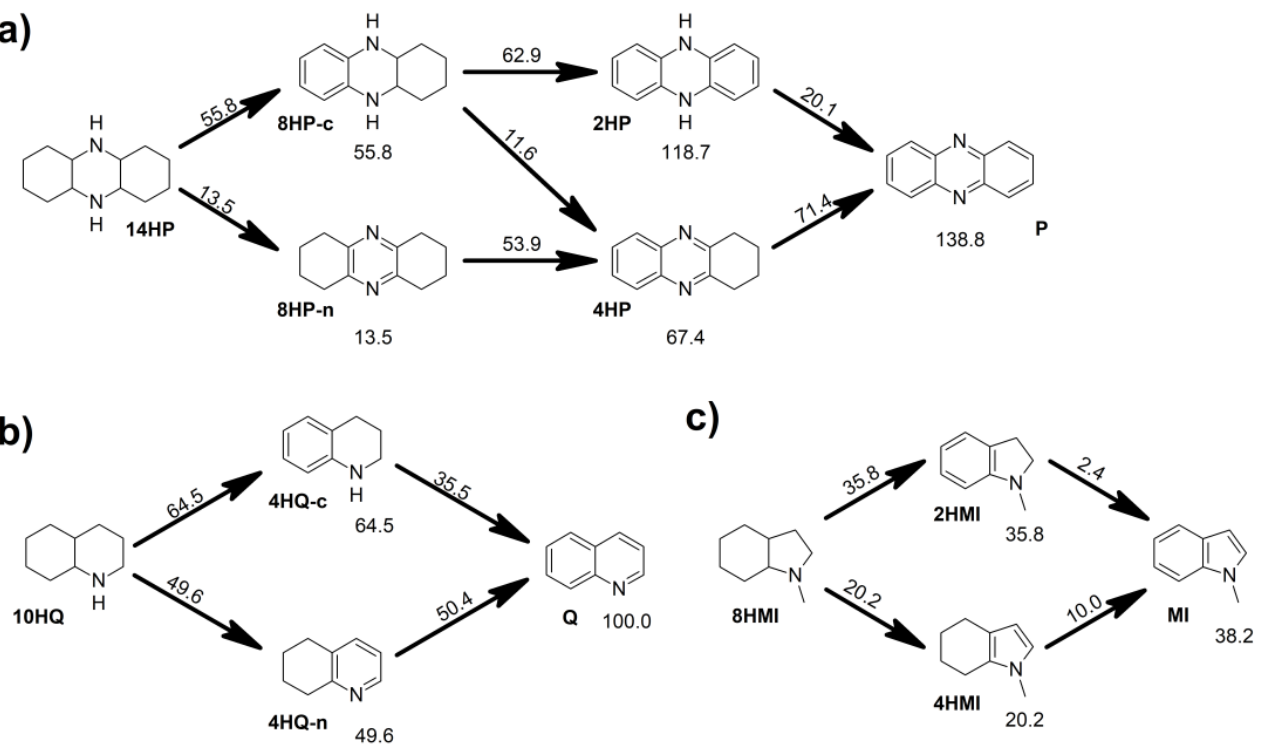
Figure 5. Thermodynamic profile of possible reaction pathways for: ( a ) 14HP, ( b ) 10HQ and ( c ) 8HMI. Values of potential-free energies (kJ/mol) shown below structural formulas for all compounds and intermediates were relative to initial, fully hydrogenated compounds for which respective enthalpies of formation was set to zero. Values (kJ/mol) shown above arrows corresponded to the difference in potential-free energies for each corresponding reaction.